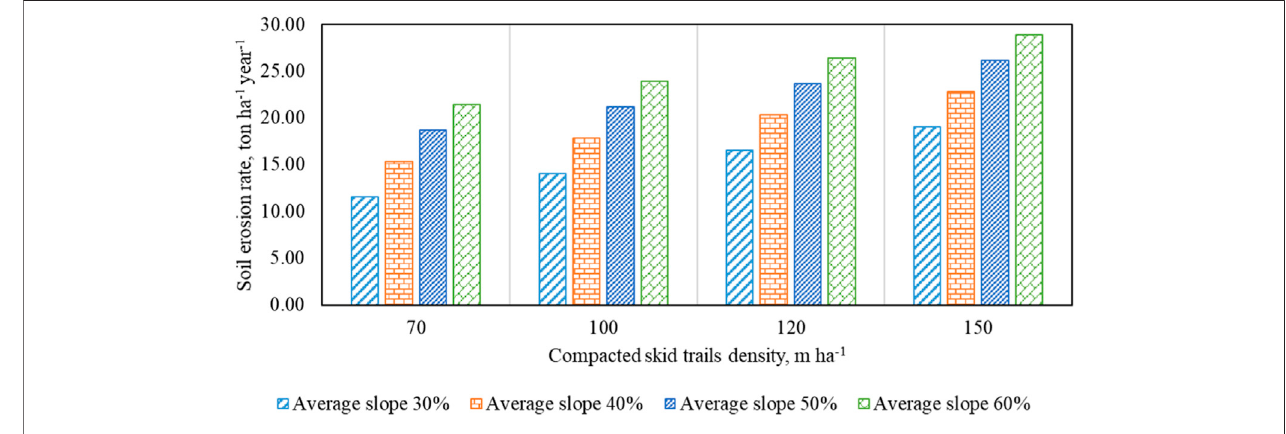
FIGURE 9 | Changes in soil erosion rate (ton ha − 1 year − 1 ) under various